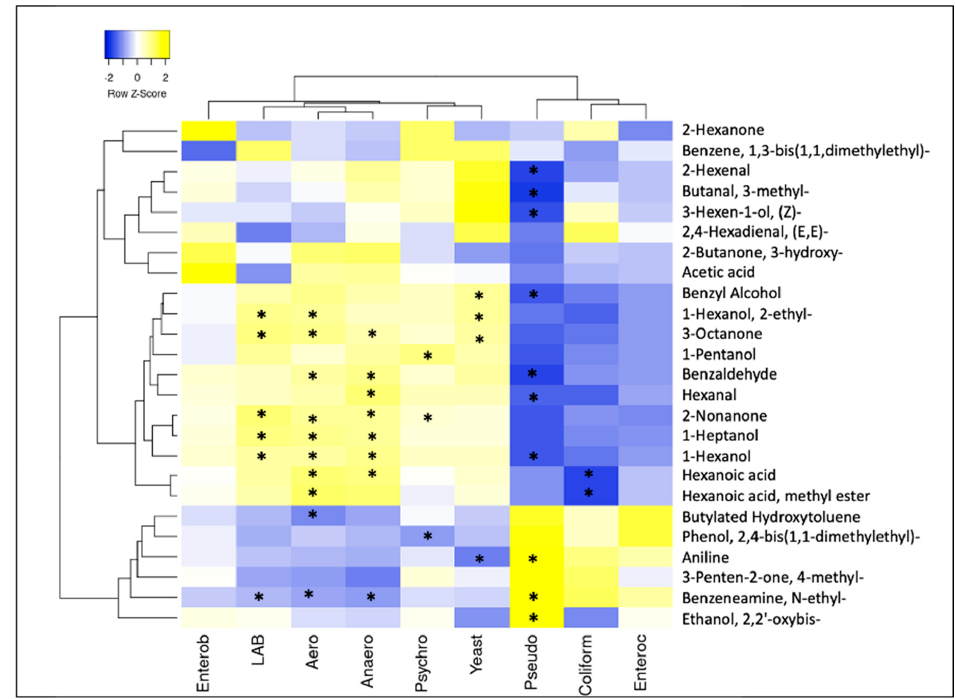
Figure 8. Spearman rank correlations among the VOCs and microbial groups. Enterob = Enterobacteriaceae ; LAB = lactic acid bacteria; Aero = aerobic mesophilic bacteria; Anaero = anaerobic mesophilic bacteria; Psychro = psychrotrophic bacteria; Yeast = yeasts and molds; Pseudo = Pseudomonas spp.; Coliform = coliforms; Enterococ = enterococci. Left side dendrogram is identifying, by Euclidean analysis, the three major different clusters among the VOC variables. * Significance of correlations at p < 0.05 by Pearson